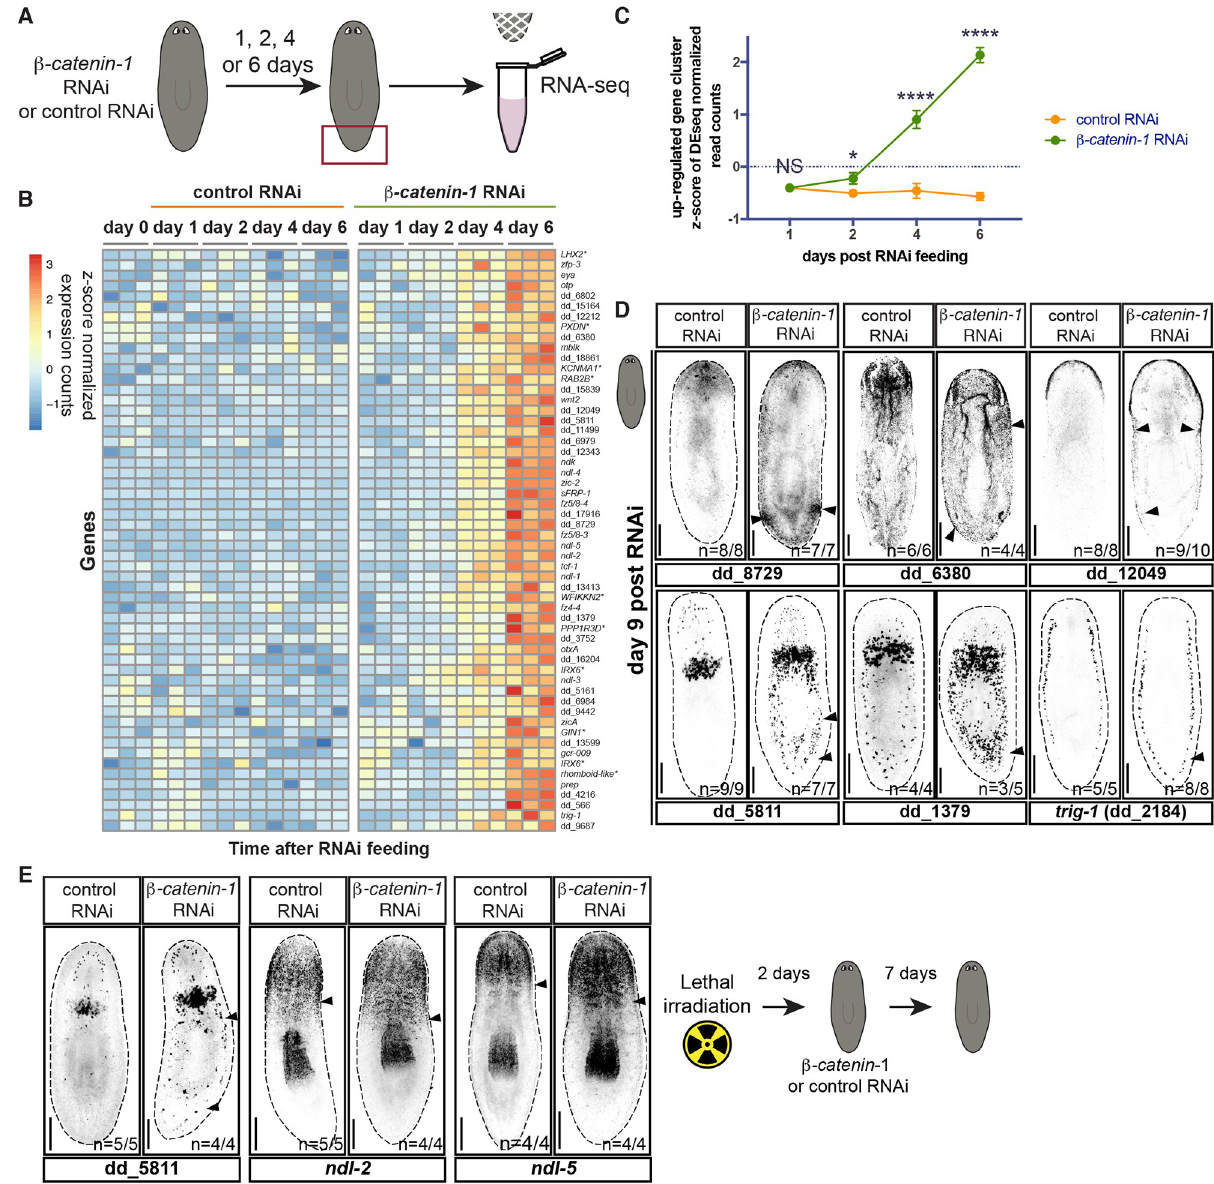
Fig 2. An anterior program of gene expression is acutely up-regulated after β -catenin-1 inhibition in planarians. (A) Experimental scheme for RNA sequencing. Schmidtea mediterranea adults were fed once with control or β -catenin-1 dsRNA. Tails were collected in trizol 1, 2, 4, and 6 days after feeding for RNA sequencing. Red box indicates tissue collected. (B) 56 genes are up-regulated early after β -catenin-1 RNAi in planarian tails. Heatmap displaying gene expression counts as z-scores for indicated timepoints post-RNAi feeding. � indicates annotation by best BLAST hit. Gene list provided in S2 Table. (C) Up-regulation of gene expression begins by day 2 post- β -catenin-1 RNAi. Mean z-score of gene expression counts is plotted for 56 genes up-regulated in 2(B) at indicated time points post-RNAi feeding. Data is plotted as mean ± S.D. � p < 0.05 ���� p < 0.001 (D) Validation of genes up- regulated after β -catenin-1 RNAi. FISH for indicated transcripts at day 9 post RNAi in unamputated animals. Images are presented in grayscale with color inverted. (E) Posterior expansion of anterior expression domains after β -catenin-1 RNAi is irradiation insensitive. FISH for dd_5811, ndl-2 , and ndl-5 after control and β -catenin-1 RNAi in irradiated animals during homeostasis. Arrows indicate posterior boundary of gene expression. Images are presented in grayscale with color inverted. Scale bars, 200 μ m.